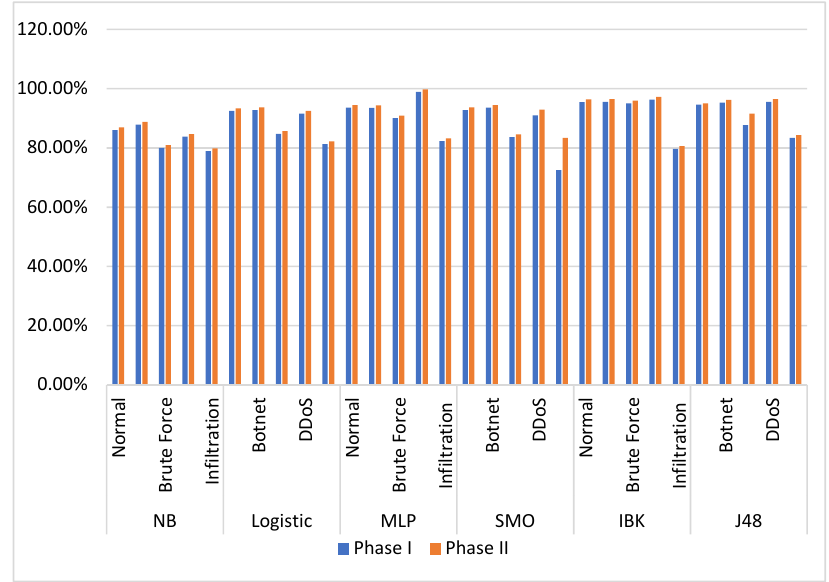
Figure 4. Accuracy of each classifier in classifying different classes in GTCS.